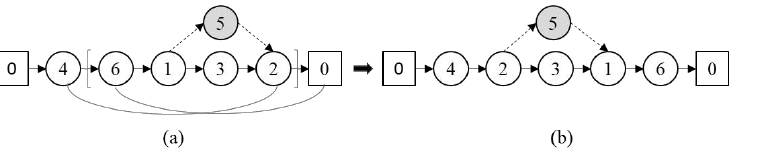
Figure 6. An example of a Swap move: ( a ) displays the TSP-D solution, tspd , before applying Swap ; and ( b ) displays the tspd after nodes 2 and 5 have been swapped.